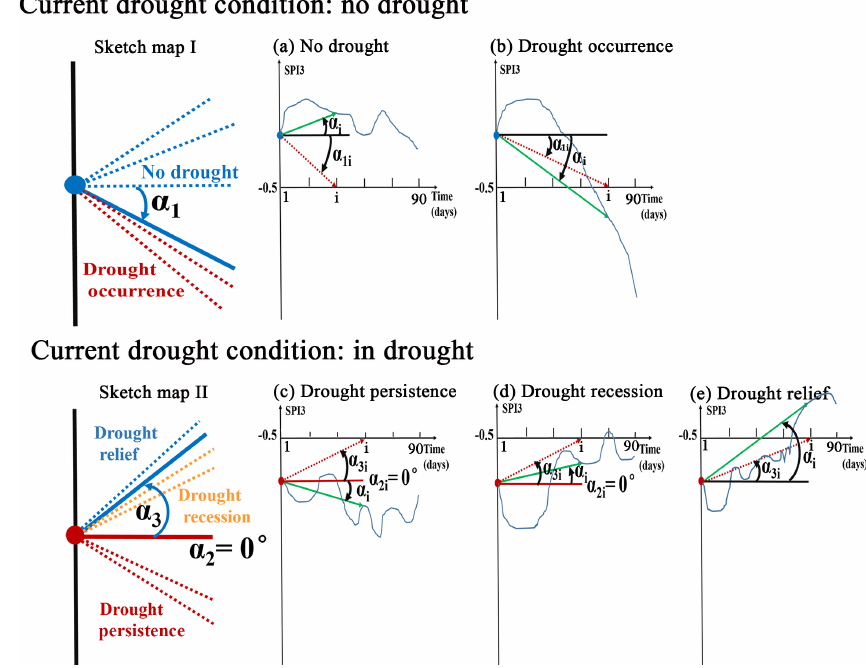
Figure 13. Rules of drought outlook based on angle comparison of prospective 90-day SPI3 curves. Sketch maps I and II show general drought outlook based on the current drought situation. Panels (a) – (b) and (c) – (e) express different situations of drought outlook associated with the rules regarding critical angles in Table